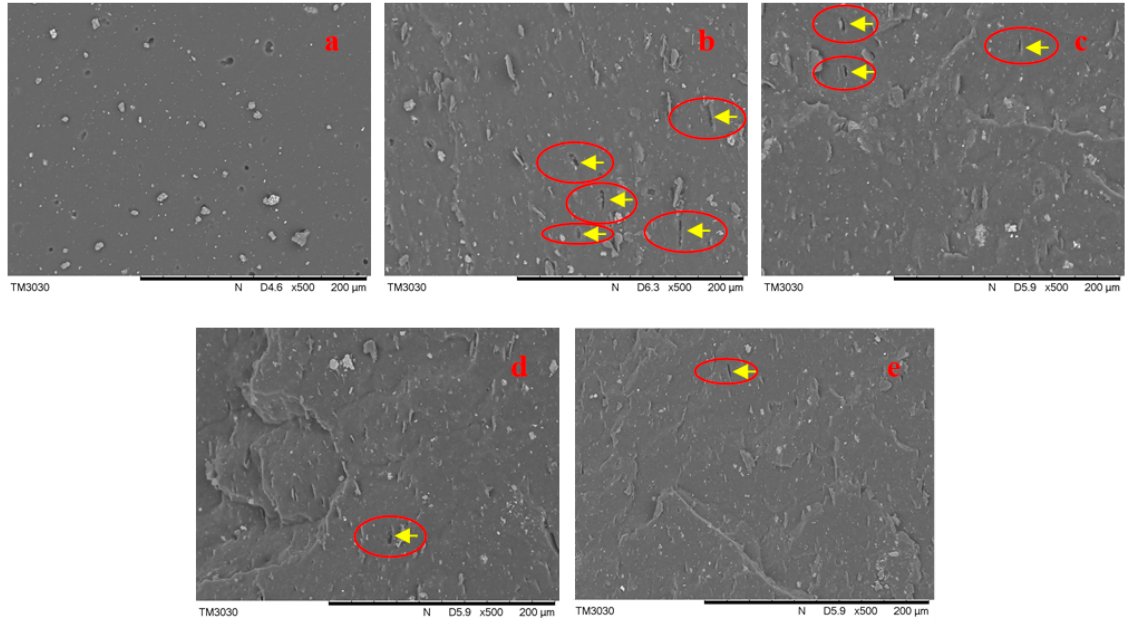
Figure 6. SEM analyses of PUR, PUR/GO and PUR/MGO. ( a ) Virgin PUR; ( b ) PUR/GO; ( c ) PUR/MGO-200; ( d ) PUR/MGO-600; ( e )